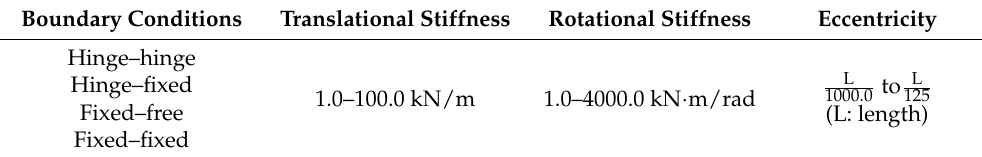
Table 9. Influencing factors and range of consideration for the buckling strength of vertical members of the prefabricated shoring